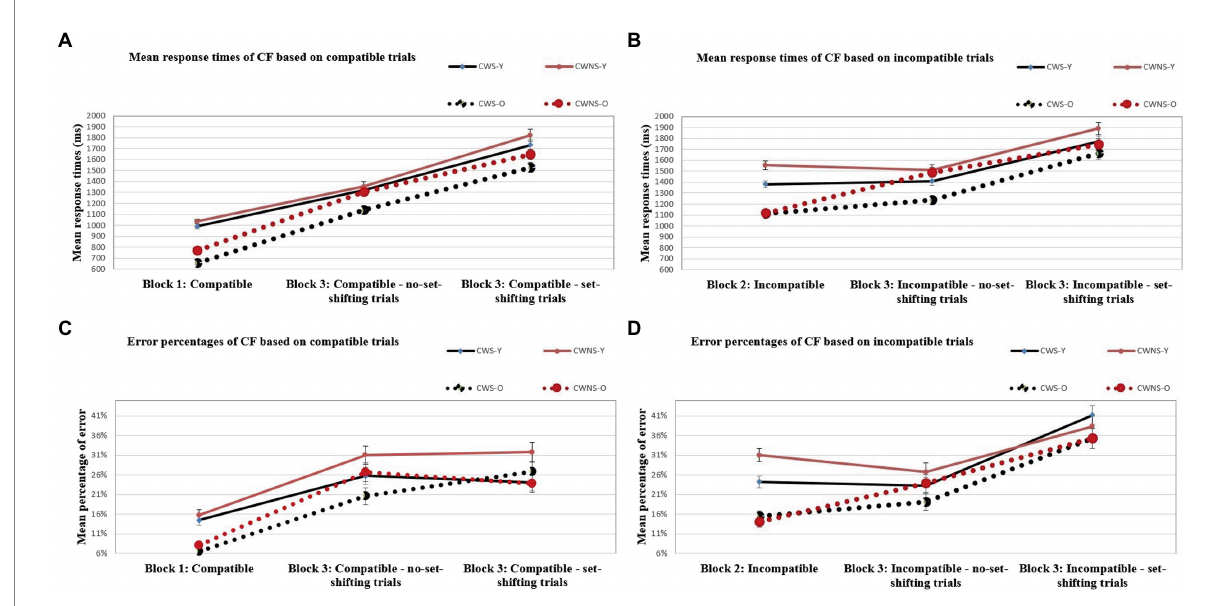
FIGURE 2 Mean response times (in ms) and error percentages of cognitive flexibility based on compatible trials ( A and C ), and mean response times (in ms) and error percentages of cognitive flexibility based on incompatible trials ( B and D ) for the CWS-Y, CWS-O and CWNS-Y and CWNS-O subgroups.